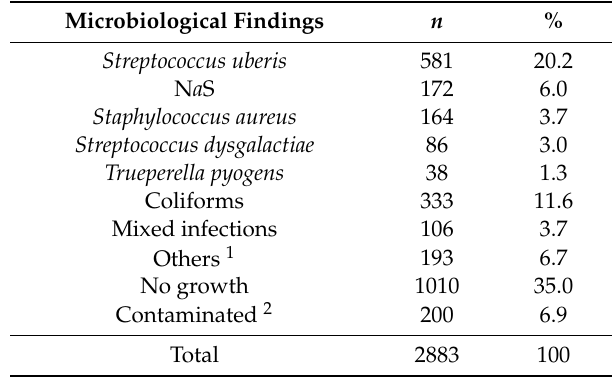
Table 1. Detailed microbiological results based on conventional diagnostic methods ( n = 2883 mastitic udder milk